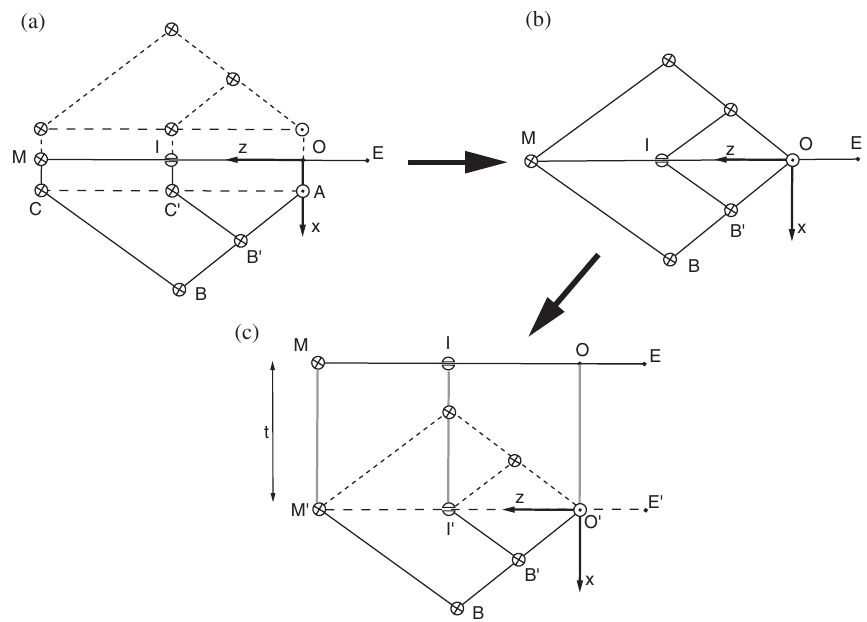
Fig. 8. 2D representation of Dionis